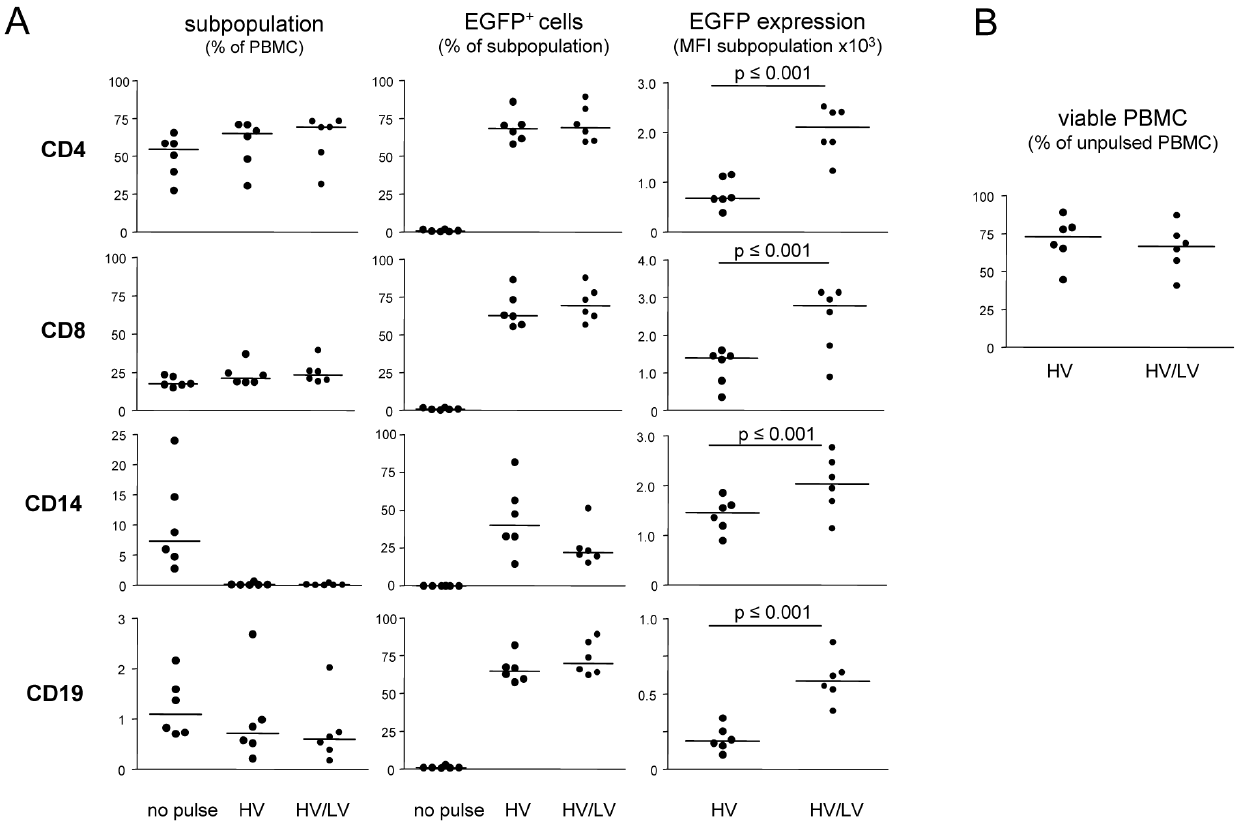
Figure 4. Transfection efficiency of defined lymphocytic and monocytic cell subpopulations within mixed human peripheral blood mononuclear cells. Freshly prepared human PBMC (3 6 10 6 ) were transfected with 4 m g pEGFP-N1. A single HV pulse of 4.5 kV/cm for 400 m s or combined with a LV pulse of 0.75 kV/cm for 3 ms was applied by the ELPorator 1000 device. Non-treated PBMC served as controls. (A) Cells were incubated with directly labeled monoclonal antibodies and overall distribution of the subpopulations within mixed PBMC preparations, percentages of EGFP + cells, and EGFP expression levels within the individual populations were determined by multi-color flow cytometry after 24 h. Mean values from triplicate determinations; n=6. (B) Viability of treated cells was assessed after 24 h by propidium iodide staining. Mean values from triplicate determinations; n=6.